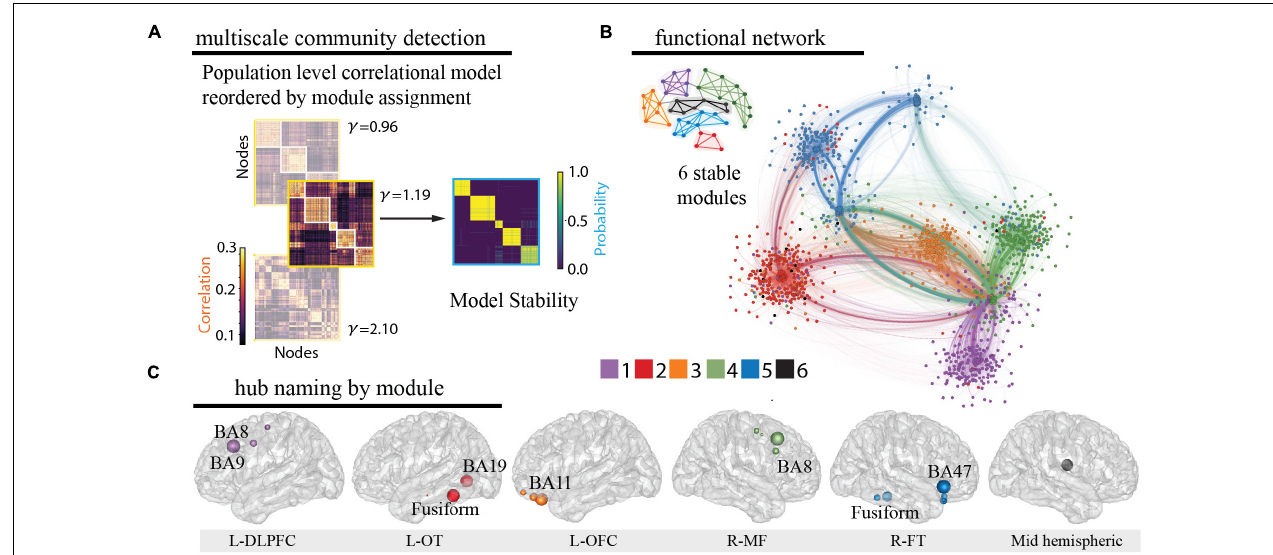
FIGURE 3 | Identification of functional modules. (A) Multiscale community detection was applied to the whole-brain model to group electrodes (nodes) into non-overlapping modules (communities) by their correlational relationships (Newman, 2006; Blondel et al., 2008). First, the population-level correlational model was reordered by the module assignment according to the modularity cost function. Network modules were identified at different levels of granularity by varying the tuning parameter (Garcia et al., 2018; He et al., 2018). Increasing partitions the brain into increasing numbers of modules with a limit equal to the number of electrodes, as shown here for 3 values of (left). Next, the stability of this clustering at each value of was assessed by calculating module allegiance, which describes the probability that any two electrodes occupy the same module on repeated module detection (Bassett et al., 2015) (right). A value of 1.19 was selected by comparing the similarity of partitions generated by values of with those of a commonly used brain atlas (Cammoun et al., 2012), resulting in 6 modules. Of note, one of the modules is small and difficult to resolve in the figure. (B) The graph of the large-scale network with module membership delineated by the color of the nodes and edges for selected of 1.19 is shown along with a schematic representation of the 6 modules. (C) Hubs for each module were identified by selecting electrodes with the lowest 10% participation coefficients. Values were then averaged for each Lausanne brain region per module and weighted by the distribution of electrodes across Lausanne regions in all modules. Hub weight is indicated by the size of hub, and module assignment is indicated by hub color. Module 5 contained insufficient number of electrodes for hub identification (0.3% of total sample) and coefficients across all electrodes were utilized to name this module. L-DLPFC, left dorsolateral prefrontal cortex; L-OT, left occipitotemporal cortex; L-OFC, left orbitofrontal cortex; R-MF, right medial frontal cortex; R-FT, right frontotemporal